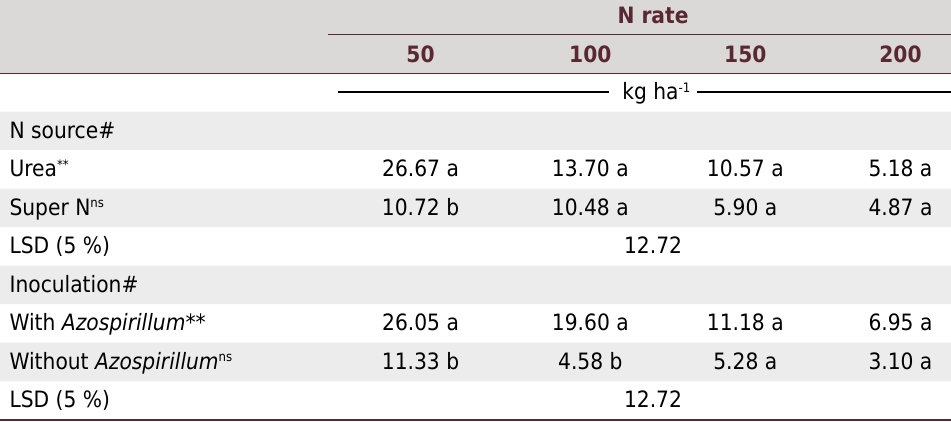
Table 4. Sources, inoculation, and nitrogen rate interaction for agronomic efficiency (AE) of corn